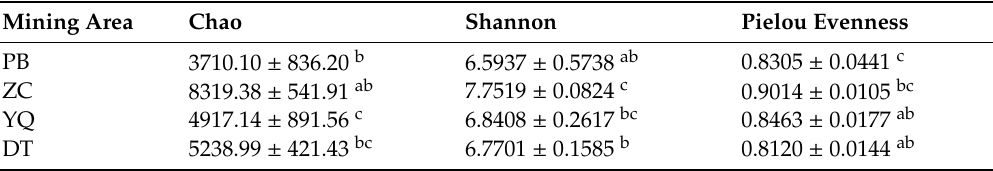
Table 1. The alpha diversity index of soil microorganisms in the four mining areas. Mining Area Chao Shannon Pielou Evenness